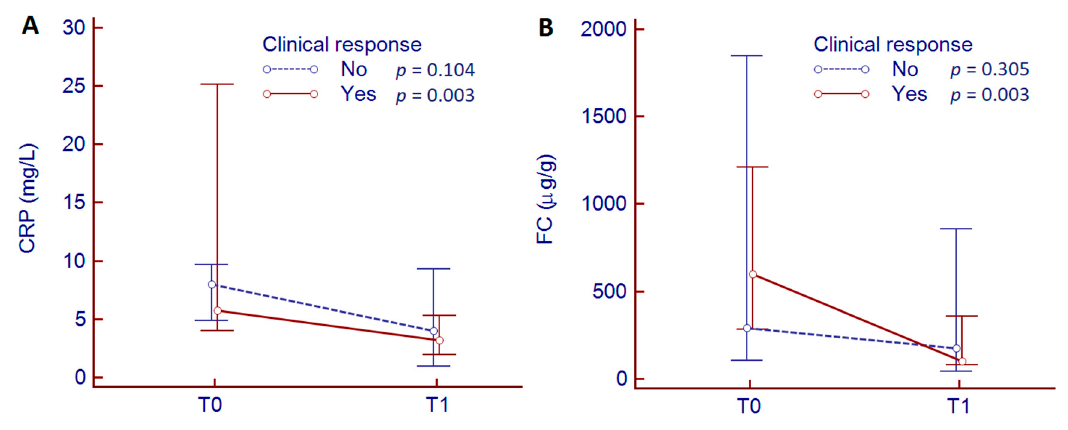
Figure 5. Reduction of CRP ( A ) and FC ( B ) values between baseline (T0) and 10 weeks (T1) of biologic therapy according to treatment response.